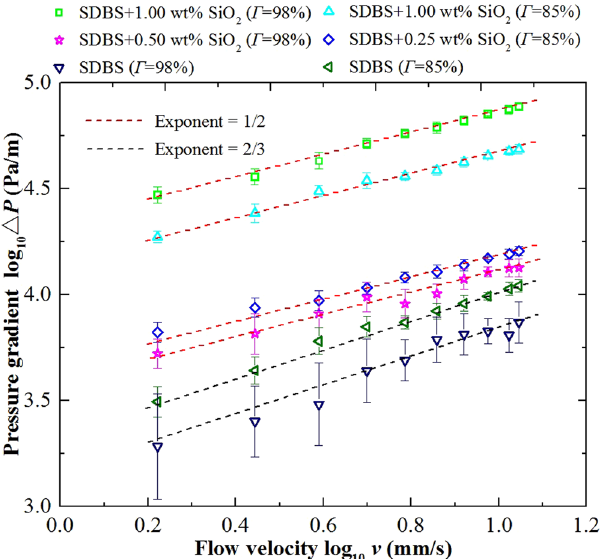
Figure 10. Logarithm of pressure gradient ∆ P for foam flow in a crack vs logarithm of flow velocity v at two foam qualities: 85% and 95%. SDBS concentration was kept at 0.1 wt% and SiO 2 nanoparticle concentration was